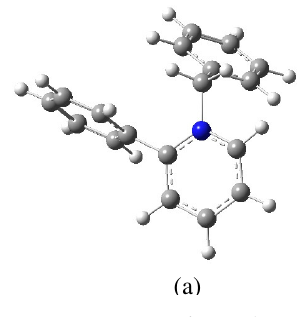
Figure 2. Conformers of (a) Stacked and (b)